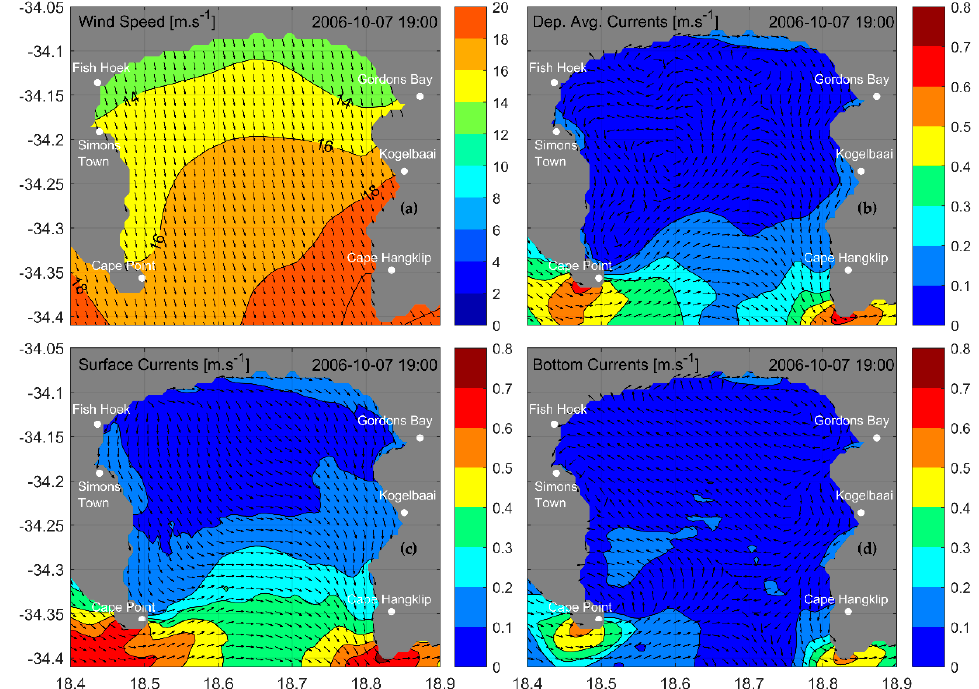
Figure 13. Depth-averaged ( b ), surface ( c ) and bottom ( d ) currents in False Bay under north-north-westerly winds ( a ). No noticeable gyre circulation is established, with weak vertical shear arising from deep flows balancing wind-aligned surface flows.